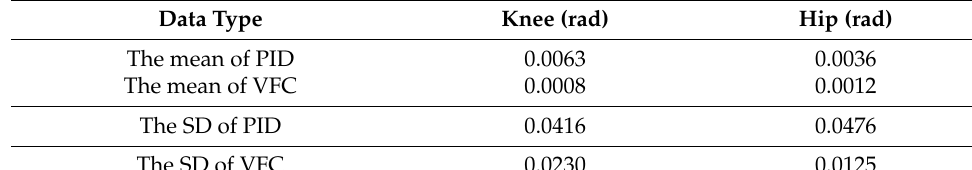
Table 4. Comparison of PID and VFC tracking errors.